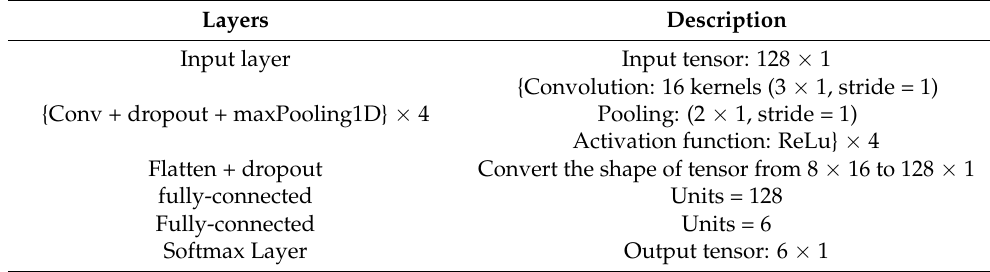
Table 2. The detailed parameters of used 1D-CNN.